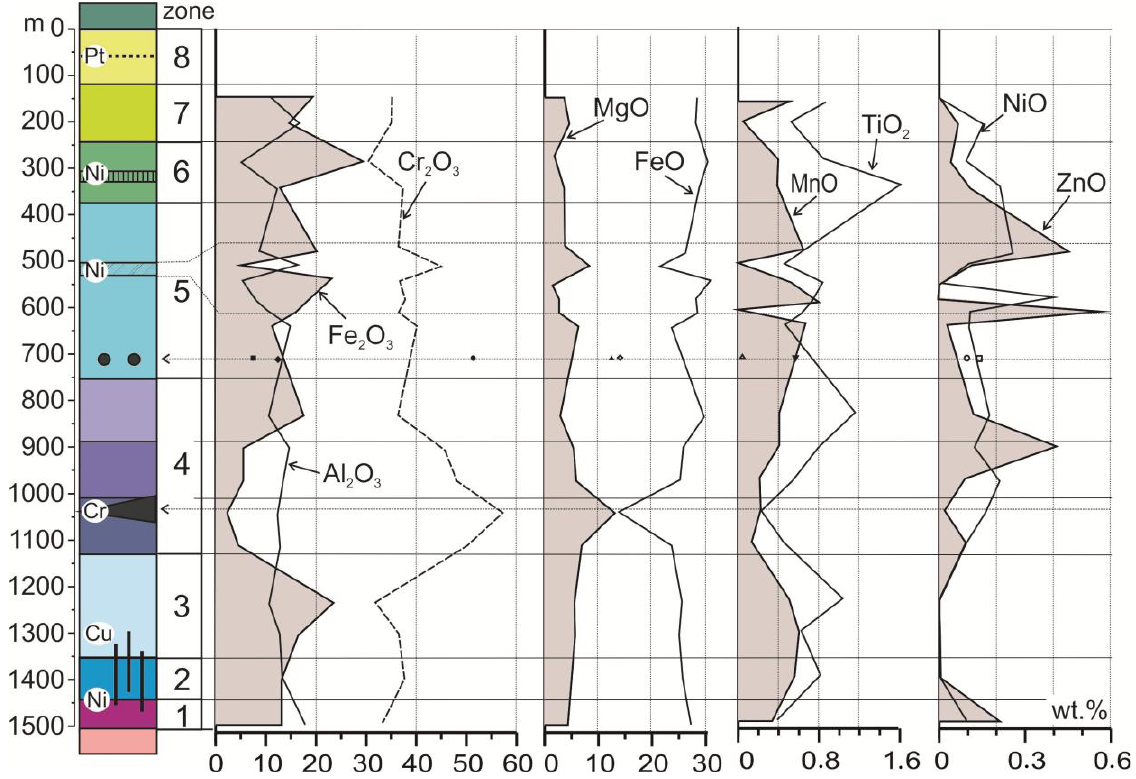
Figure 3. Variation of the Cr-spinel chemical composition of the Monchepluton layered series and Sopcheozero deposit [2]. The colors are the same as those used in Figure